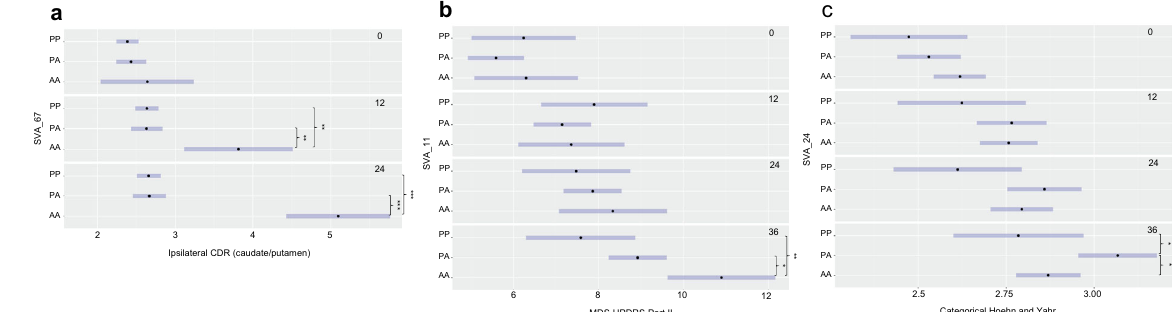
Fig. 2 Polymorphic SVAs were associated with markers of PD progression in the PPMI cohort. a PD individuals with the AA genotype of SVA_67 had a signi fi cantly higher ipsilateral caudate/putamen CDR at both 12 and 24 months compared to those with PA and PP genotypes. b PD individuals with the AA genotype of SVA_11 had a signi fi cantly higher MDS-UPDRS part II score at 36 months compared to those with PA and PP genotypes. c PD individuals with the PA genotype of SVA_24 had a signi fi cantly higher Hoehn and Yahr score at 36 months compared to those with AA and PP genotypes. 95% con fi dence intervals are represented by the blue bar. * p < 0.05, ** p < 0.01 and *** p < 0.001 (Tukey adjusted p values are reported).